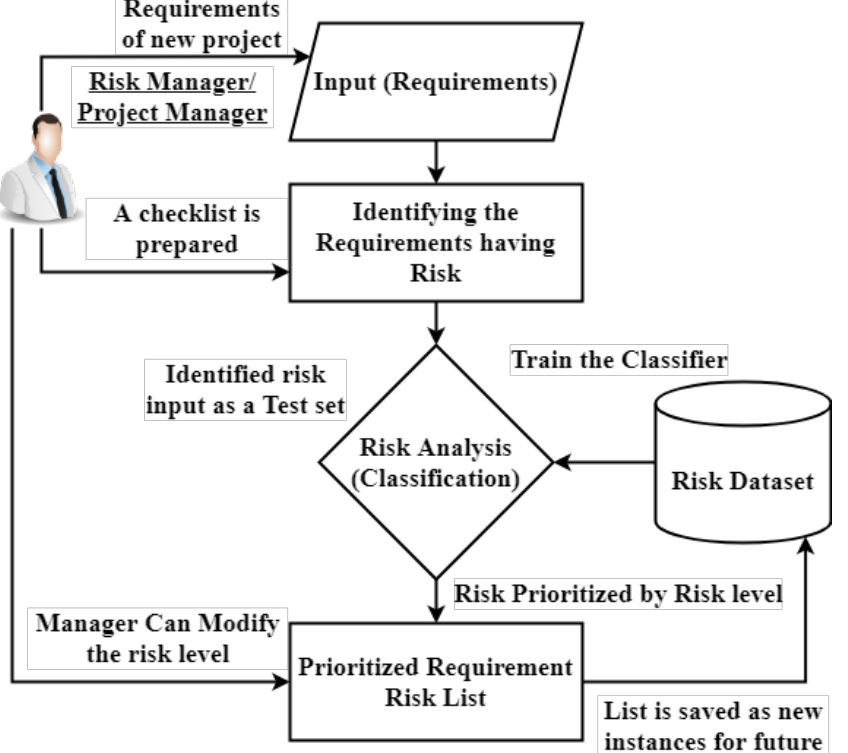
Figure 1. Requirement risk prediction